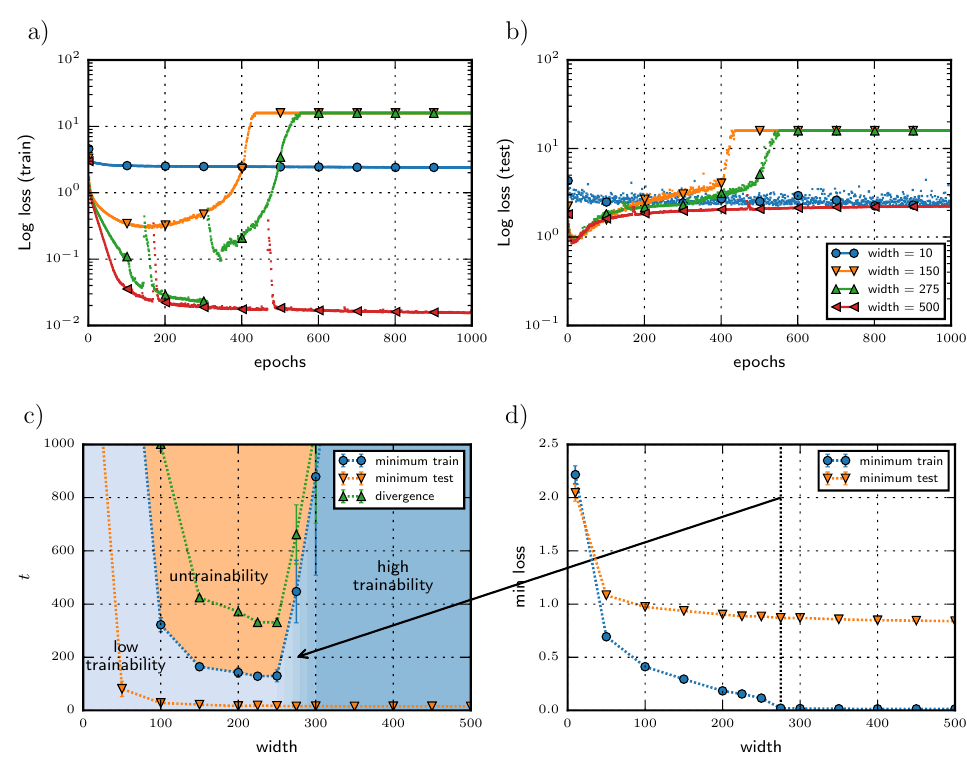
Figure 4. The regimes of a neural network over the course of its training: Evolution of ( a ) train and ( b ) test loss functions of networks of various widths. Panels ( a , b ) show single typical training runs of the full set which we explored. ( c ) Average times (in epochs) taken by the networks to reach the minima of the train loss and of the test loss functions, and to diverge (i.e., reach the plateau of the train loss). For each network width, we calculate the averages and standard deviations of these times (represented by error bars) over ten independent runs trained on HASYv2. ( d ) Average values of minimum loss at the train and test sets reached during individual runs (different runs reach their minima at different times). These averages were measured over the same ten independent realizations as in panel ( c